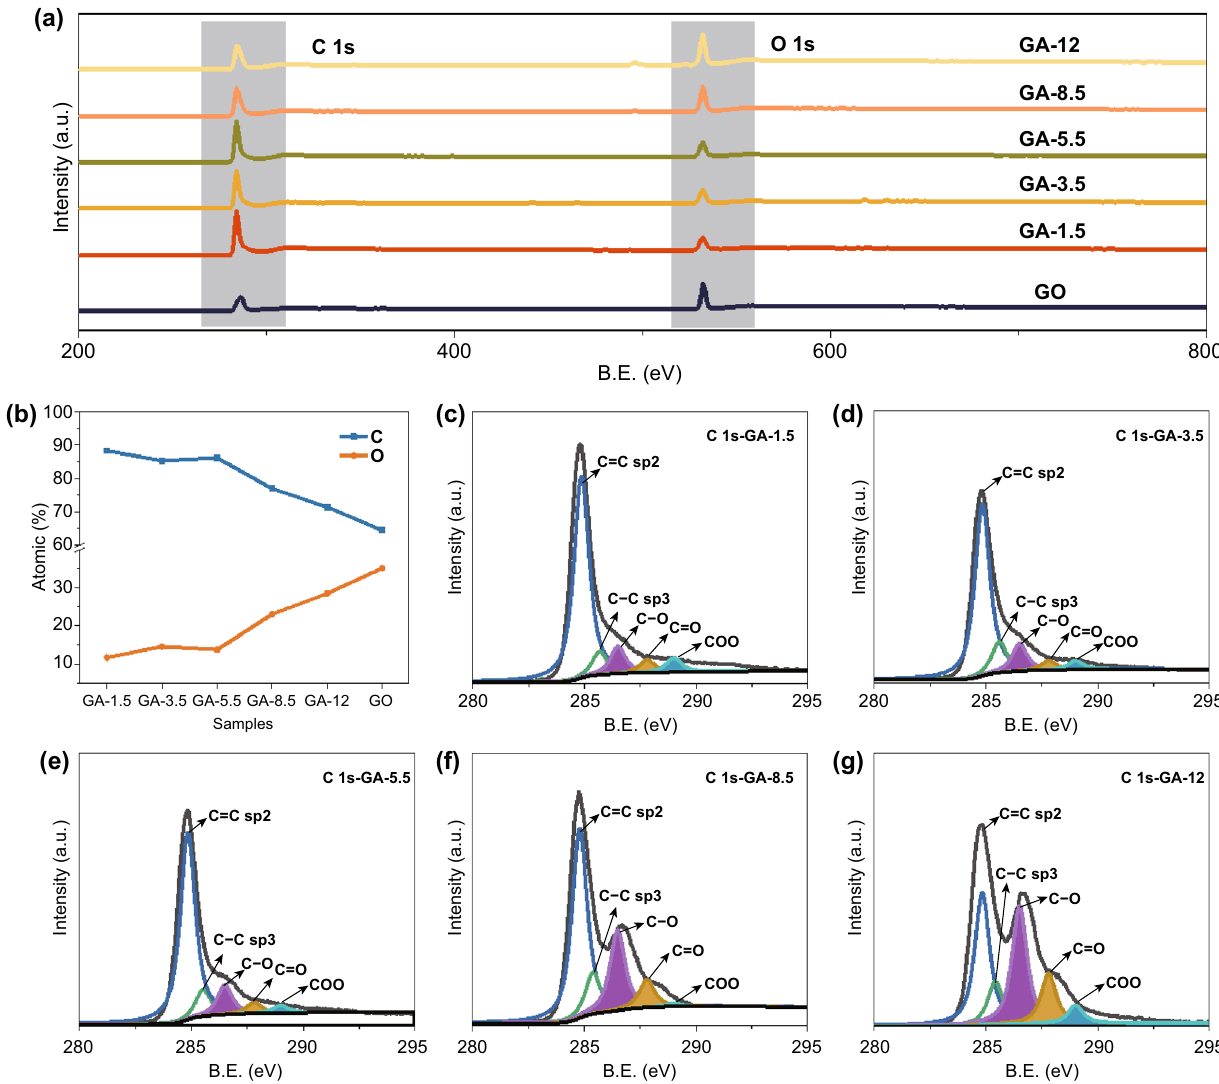
Fig. 3 a XPS spectra of GA samples and GO, b percentages (at%) of C and O in the GA samples and GO, and C 1s core level spectra for GA samples: c GA-1.5, d GA-3.5, e GA-5.5, f GA-8.5, and g